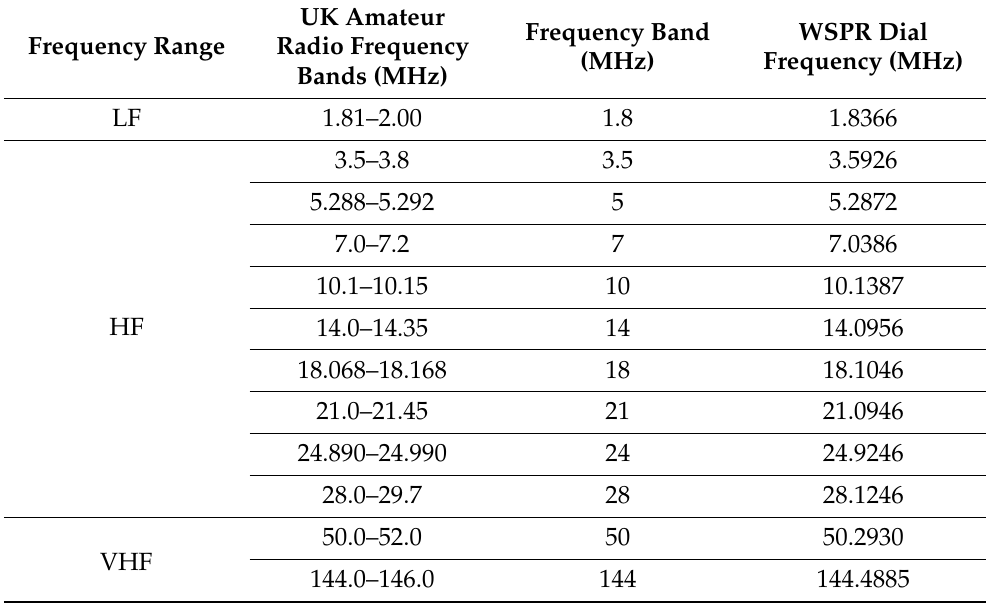
Table 1. Frequency bands assigned to radio amateurs in the United Kingdom and the WSPR dial frequencies (not